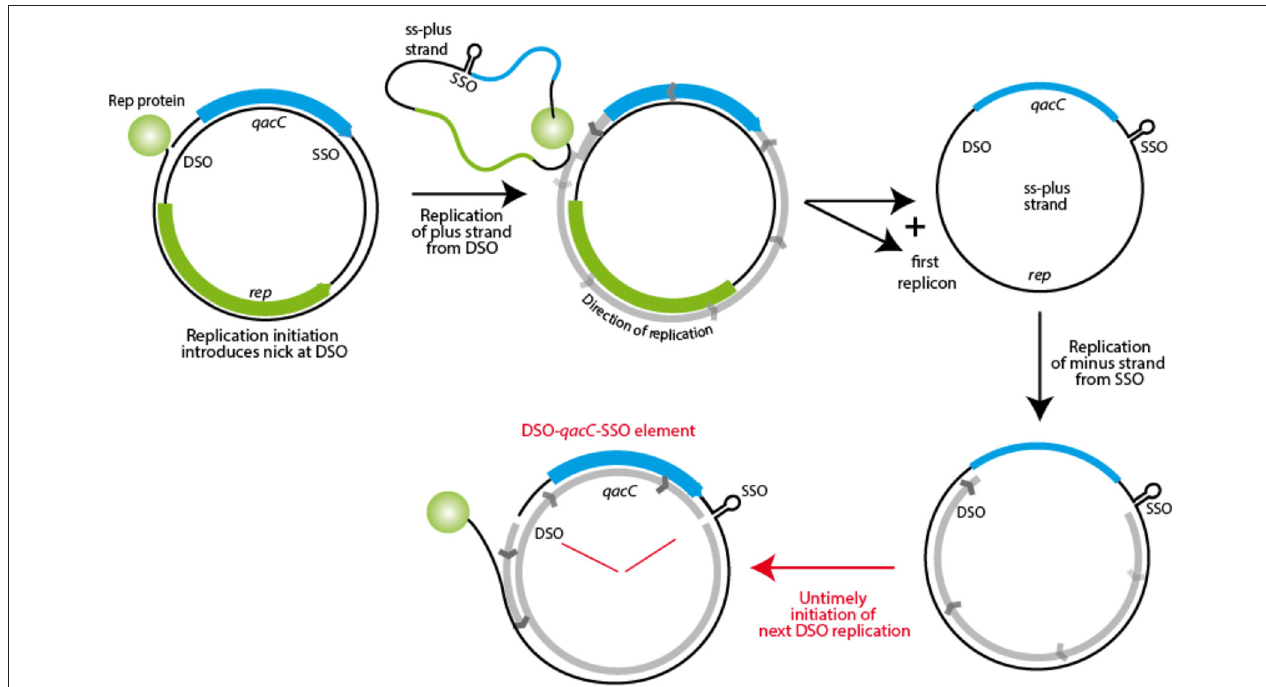
FIGURE 7 | Model for mobility of the qacC locus. The first step in RC-replication is production of the plus strand, resulting in the template plus strand as an ssDNA intermediate. This is subsequently replicated from the SSO, but when a new nick is introduced in this DNA before replication is completed, a fragment containing qacC , flanked by nicked DSO and SSO is the result. This DSO- qacC -SSO element could then be incorporated into an alternative plasmid.